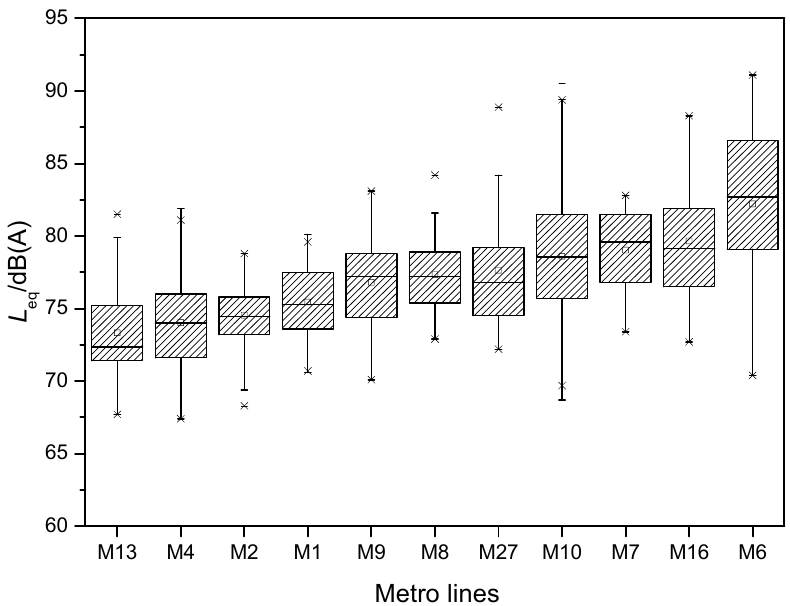
Figure 7. Equivalent SPL of interior noises for different metro lines.